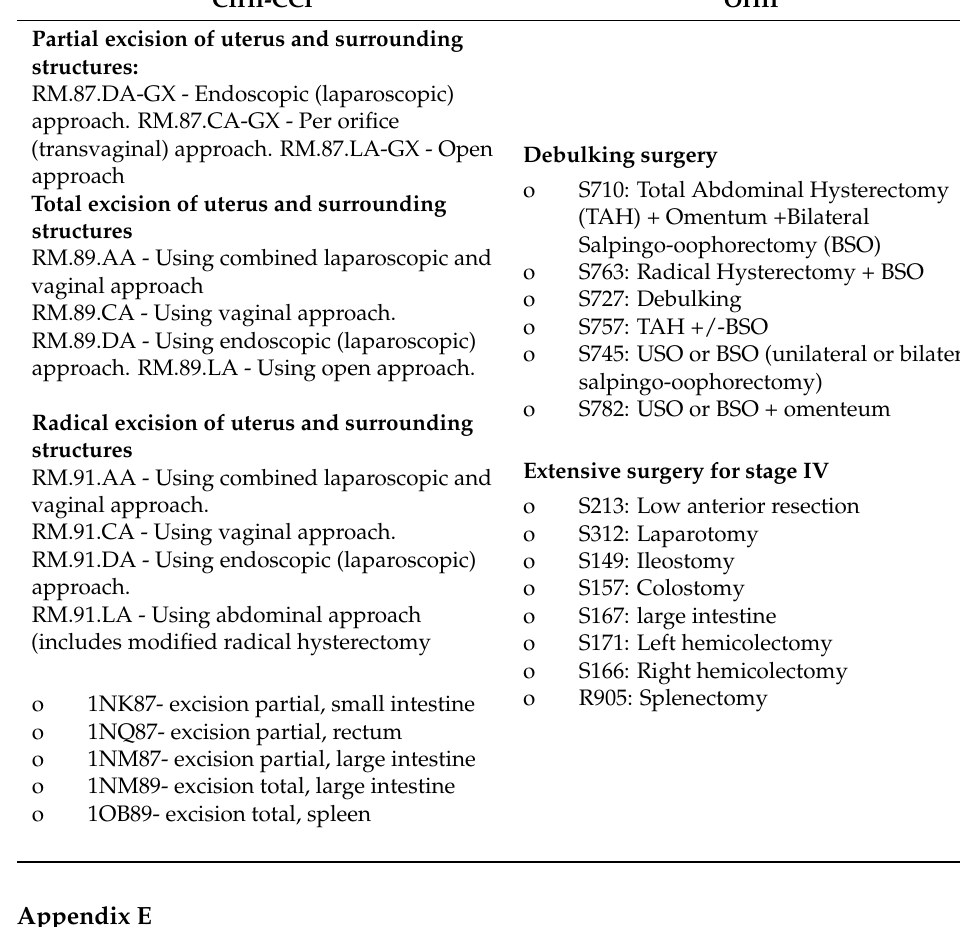
Table A4. List of ovarian cancer surgical codes in OHIP and CIHI-CCI. CIHI-CCI OHIP